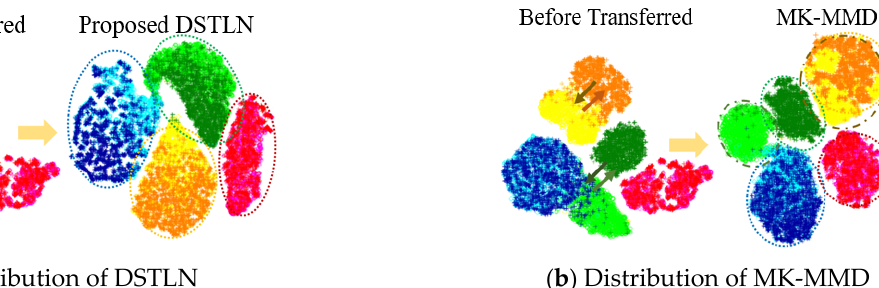
Figure 15. Comparison of subdomain and global domain transfer learning.( Proposed DSTLN method aligns the distributions of relevant subdomains within the same class in both source and target domains.)